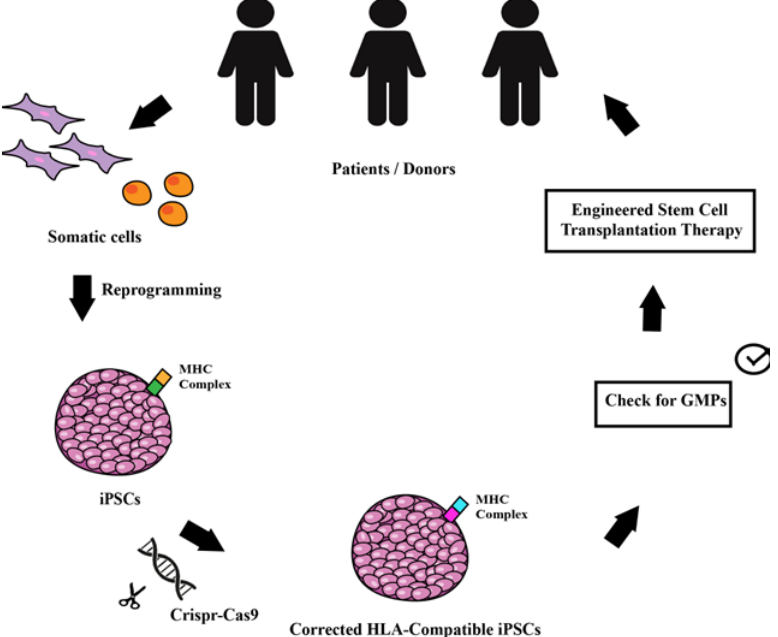
Figure 1. Schematic drawing of the workflow allowing the use of genetically modified iPSCs for transplantation therapy. Starting from the patients, somatic cells can be reprogrammed into iPSCs that are then corrected or modified with CRISPR/Cas9 gene editing with the aim to modify the MHC complex to make them compatible for a wider population of patients. The engineered stem cells can be used for autologous and/or for allogeneic transplantation and used as therapy for monogenic disorders.